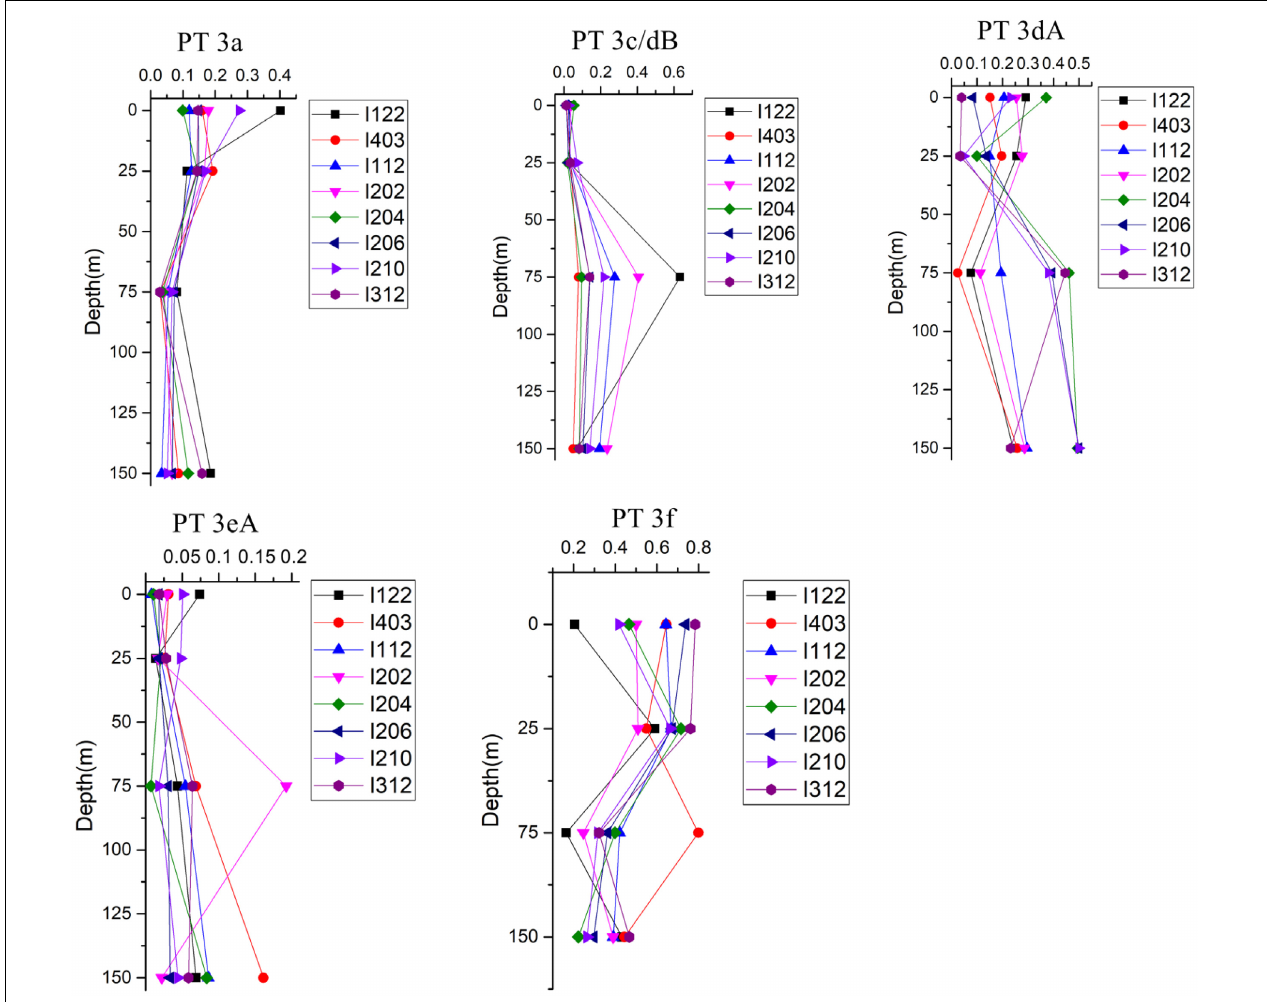
FIGURE 5 | Vertical distribution of relative abundance of different Synechococcus pigment types in eastern Indian Ocean